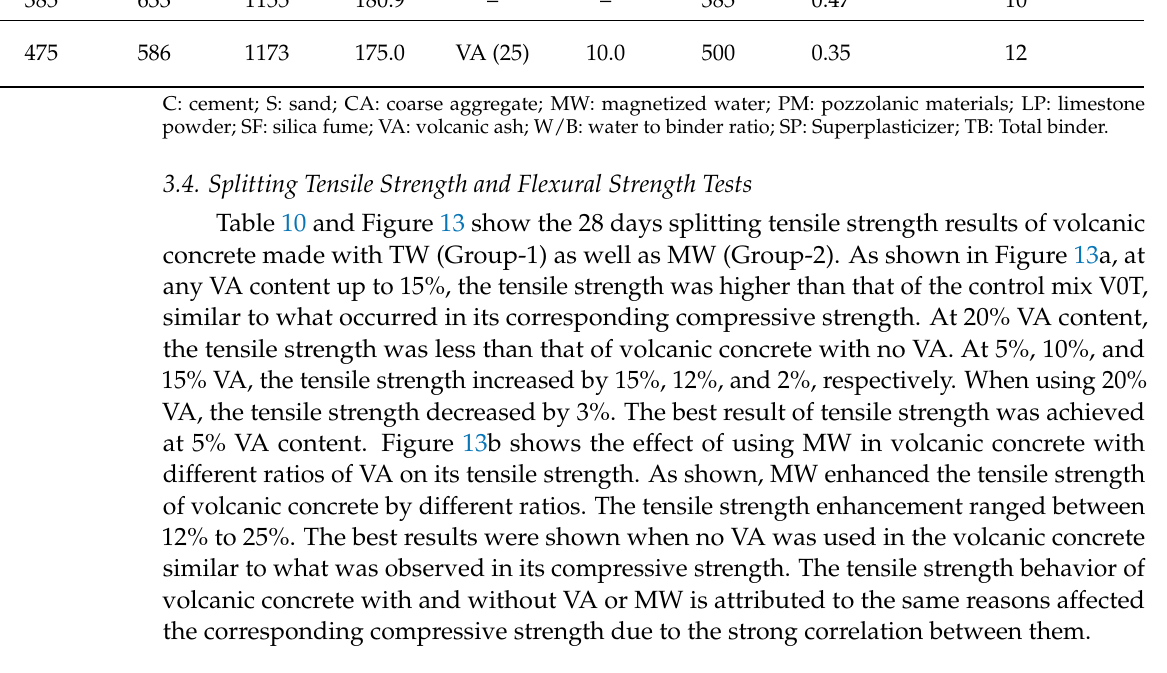
Table 10. Splitting tensile strength and flexural strength values of volcanic concrete at 28